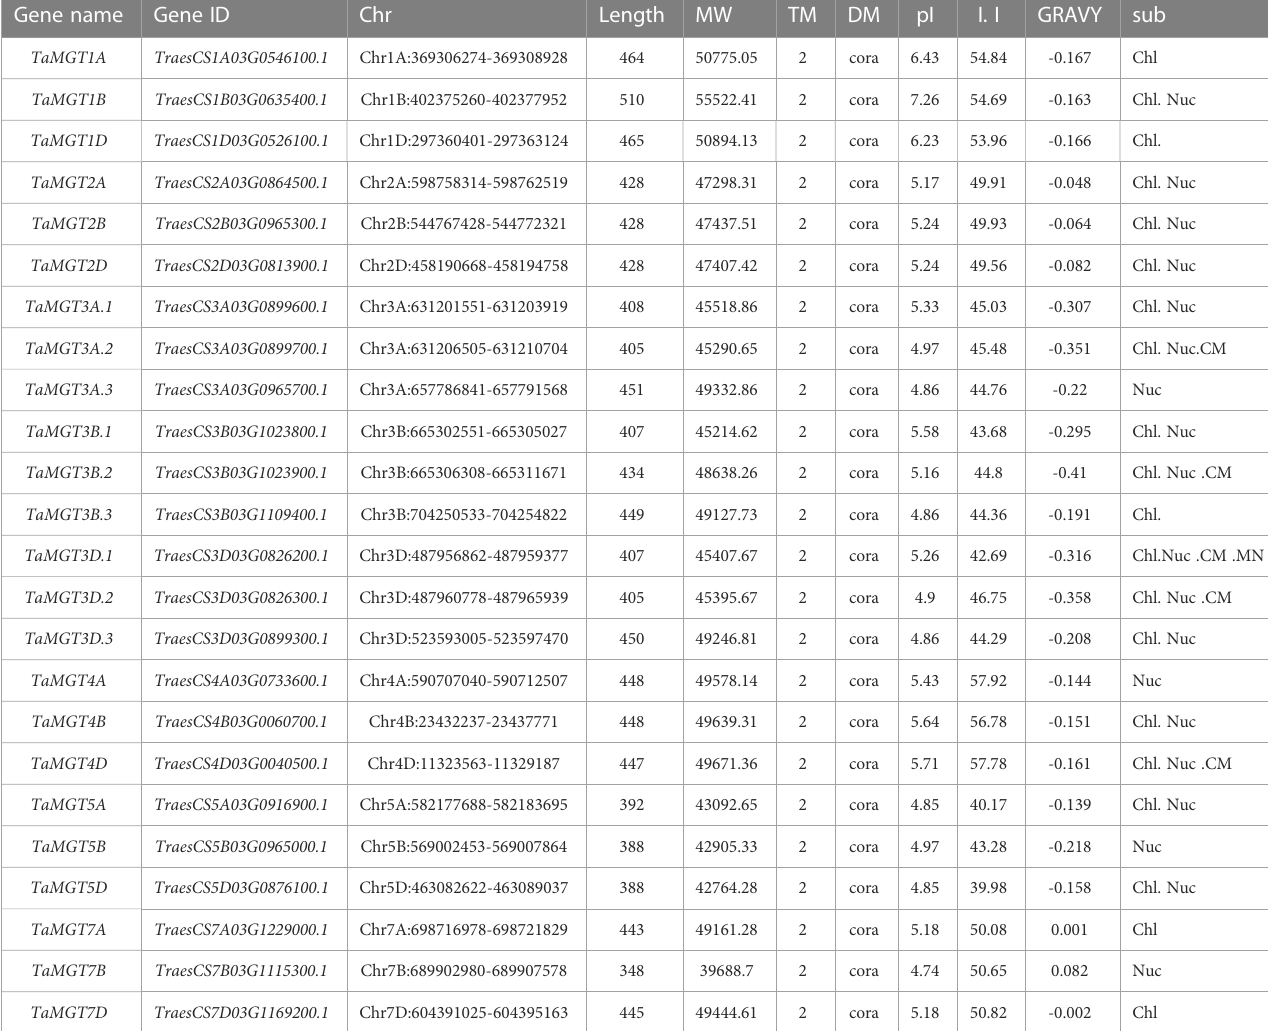
TABLE 1 TaMGTs protein features and prediction of subcellular